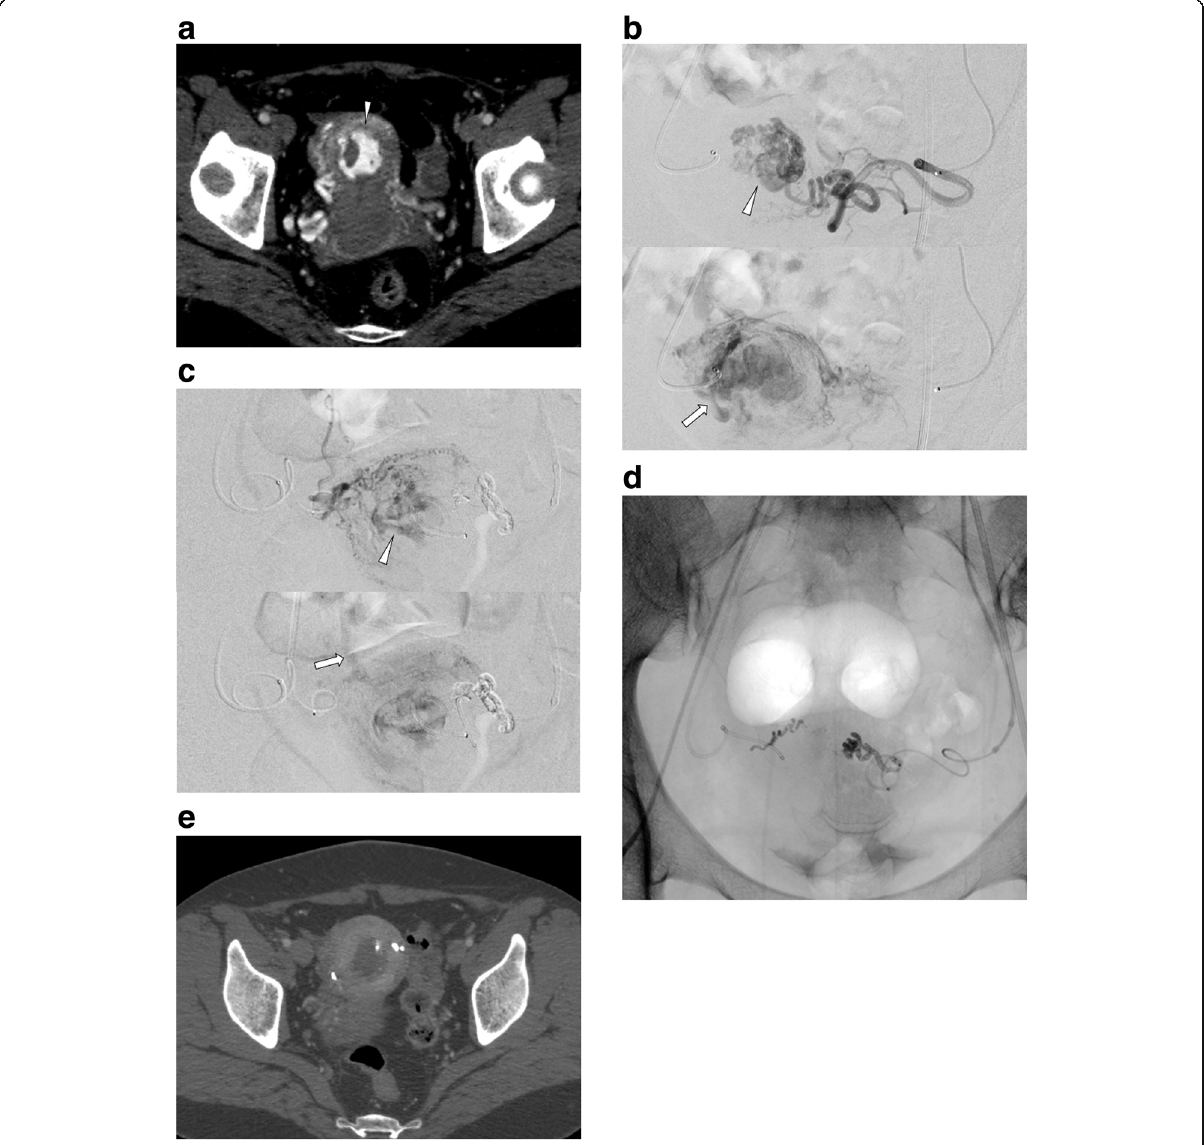
Fig. 2 A 42-year-old woman with vaginal bleeding caused by retained placenta. a. Arterial phase CE-CT showed intrauterine enhancing lesion (arrowhead). b, c. Bilateral uterine arteriogram showed dilated vascular channel (arrowhead) in the arterial phase. Venous drainage (arrow) was depicted in the capillary phase through the vascular channel. d. Bilateral uterine arteries were embolized using 25% NBCA diluted with iodized oil. After the TAE procedure, expectant management was chosen and no re-bleeding was observed. e. At 1 month after the TAE procedure,